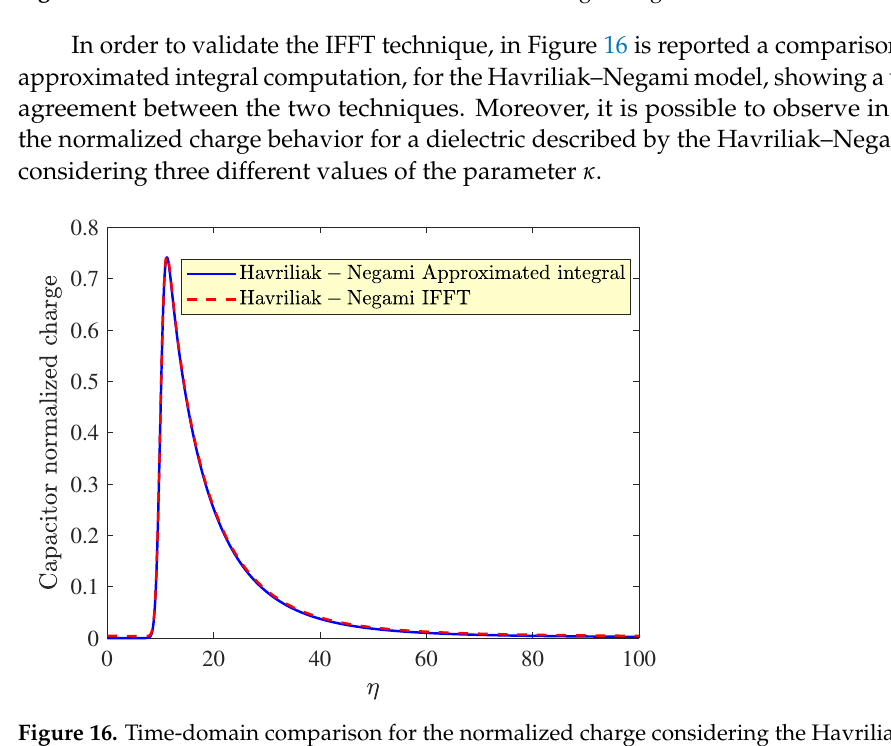
Figure 15. Time-domain behavior of the normalized charge using the four dielectric laws proposed.